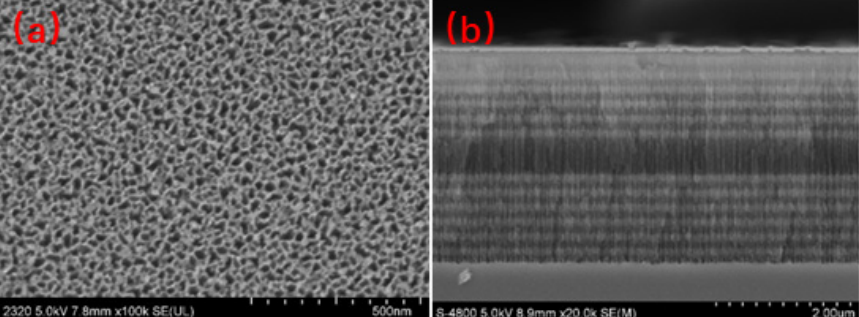
Figure 3. ( a ) SEM surface view and ( b ) SEM cross-sectional view of the PSM.